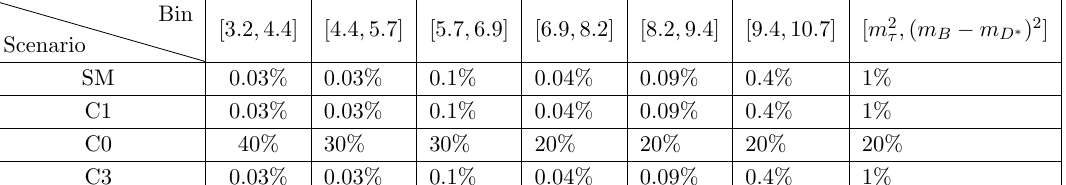
Table 2. Relative di(cid:11)erence in percent of the approximate binned expression of h ~ F D (cid:3) alt respect to the \standard" h ~ F D (cid:3) i (cid:28) for the SM and di(cid:11)erent NP scenarios. It corresponds to the T relative di(cid:11)erence in between the orange and blue bins displayed in (cid:12)gure 1 (normalised by the \standard" h ~ F D (cid:3) i (cid:28) i.e. the orange bins). The bins in the (cid:12)rst 6 columns correspond to the division of T the kinematic range ([ m 2 ; ( m B (cid:0) m D (cid:3) ) 2 ]) in 6 equally sized intervals. The last column corresponds to (cid:28) the whole kinematic range (not displayed in (cid:12)gure 1). Notice that, as expected, this approximation works better for smaller bins. The scenario C 0 is displayed as an example of a scenario with tensor contributions where, as expected, the two determinations should yield di(cid:11)erent results.